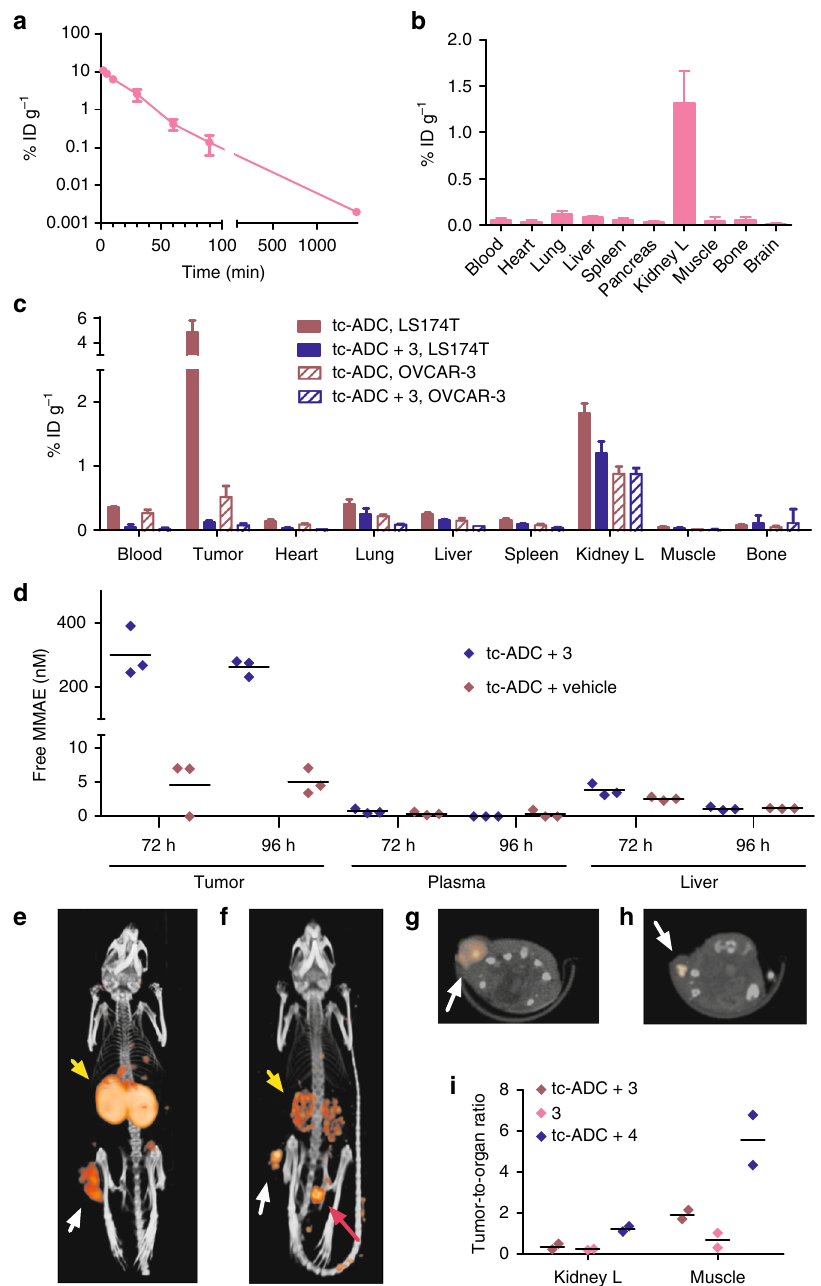
Fig. 4 In vivo assessment of activator 3 and probe 4 . a Blood kinetics of 177 Lu-labelled 3 administered i.v. at 0.335 mmolkg − 1 (calculated half-life: 12 min) and b biodistribution of [ 177 Lu]Lu- 3 in tumour-free mice 1 h post-injection. c Blocking study: biodistribution of probe [ 177 Lu]Lu- 4 (0.335 µ mol kg − 1 ) 3 h post-injection i.v. in LS174T and OVCAR-3 tumour-bearing mice pretreated i.v. with tc-ADC only (2 mg kg − 1 ) or with tc-ADC followed by 3 (0.335 mmol kg − 1 ); data represent the mean percentage injected dose per gram (% ID g − 1 ) with s.d. ( n = 4). d MMAE concentration in LS174T xenografts, plasma and livers of mice injected with tc-ADC (2 mg kg − 1 ; n = 3) followed 48 h later by activator 3 (0.335 mmol kg − 1 ) or vehicle and euthanized 72 or 96 h post-ADC administration. e Post-mortem SPECT/CT projection of a LS174T tumour-bearing mouse pretreated i.v. with tc-ADC (2 mg kg − 1 ) followed 48 h later by the 111 In-analogue of 3 (13 nmol kg − 1 , 13 MBq, i.v.). f SPECT/CT projection of a live LS174T tumour-bearing mouse pretreated i.v. with tc-ADC (2 mg kg − 1 ) followed 48 h later by 111 In-labelled 4 (19 nmol kg − 1 , 24 MBq, i.v.). g , h Single transverse slice passing through the tumour of the mouse in resp. e , f White arrows indicate the tumour; yellow arrows indicate the kidneys; pink arrow indicates the bladder. i Tumour-to-organ ratios of [ 111 In]In- 3 with and without pre-administration of tc-ADC and tumour-to-organ ratios of [ 111 In]In- 4 with pre-administration of tc-ADC , derived from the SPECT/CT imaging ( n =